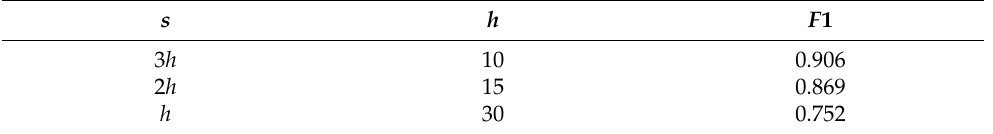
Table 4. Quantitative comparisons on F 1- score by setting three different moving strides of WLpeep- hole, respectively (here, r = 60 pixels, s = 30 pixels and λ = 10